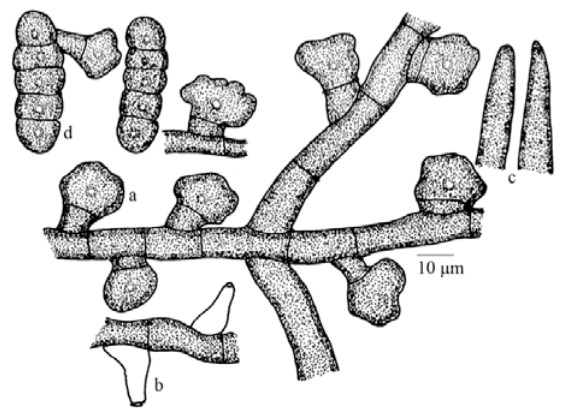
Figure 115. Meliola stenospora var . major a - Appressorium; b - Phialide; c - Apical portion of mycelial setae; d -